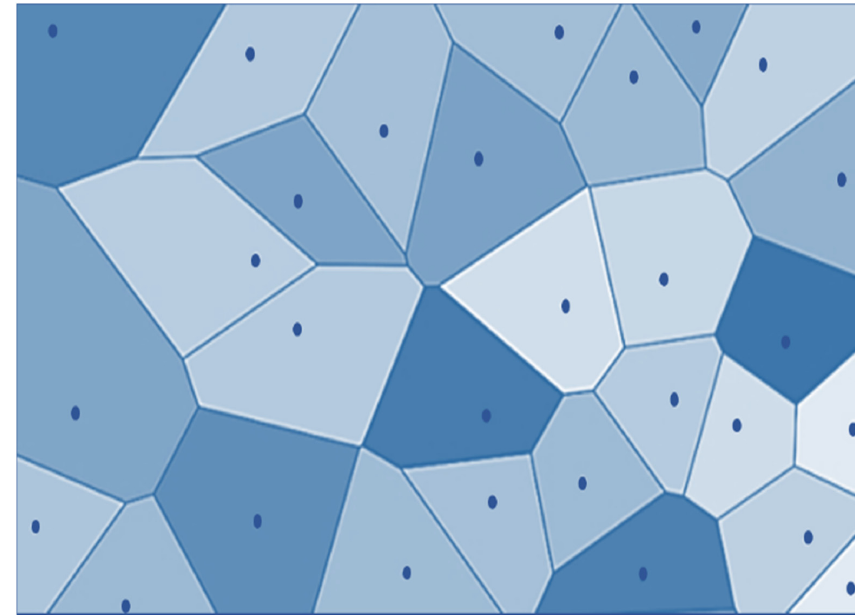
Figure 8. A Voronoi Diagram.